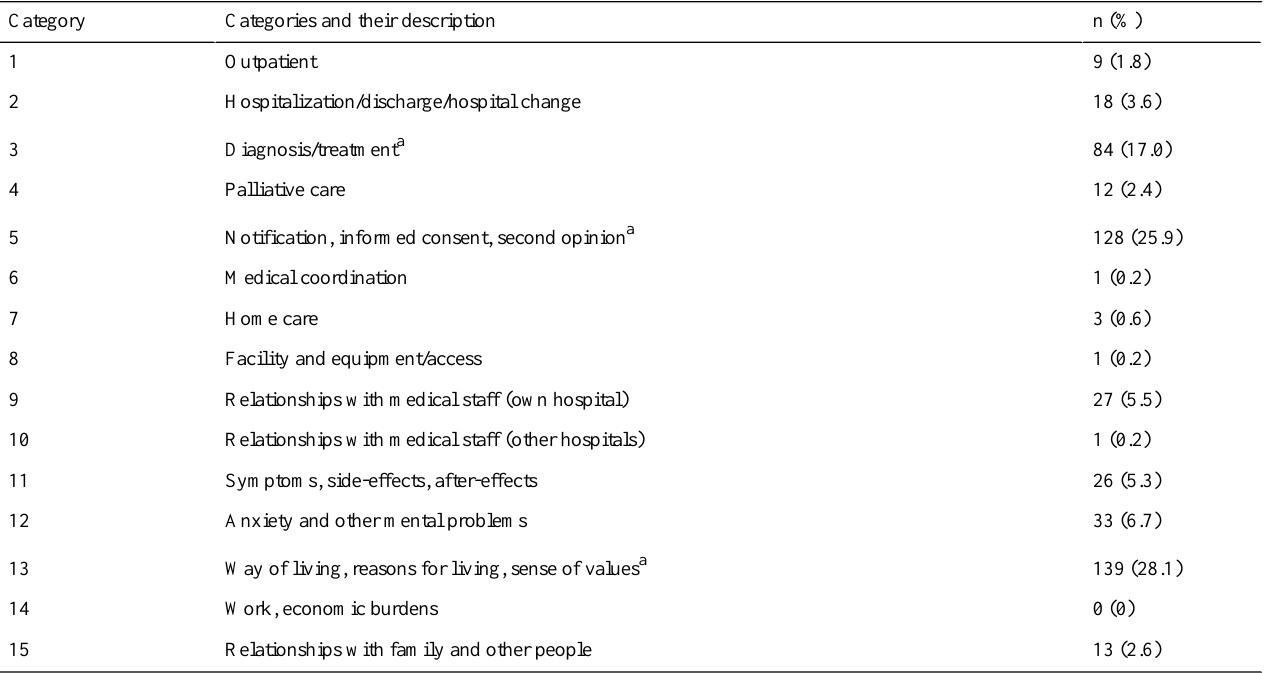
Table 2. Results of classification of patient’s dissatisfaction and anxiety in 495 sentences (n=100